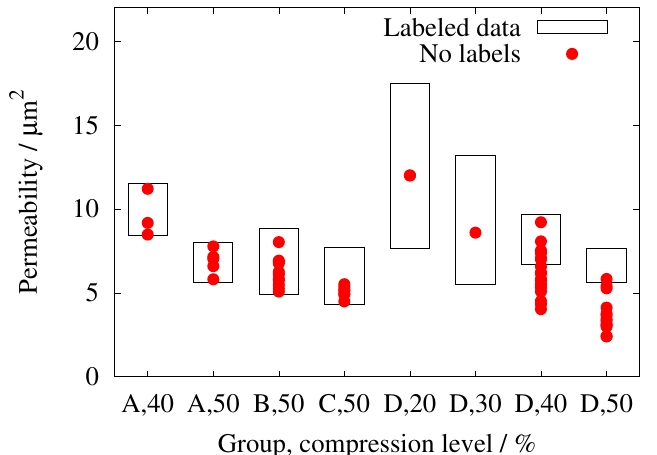
Figure 9. Predictions on unlabeled data, compared with the minimum and maximum values of the same group of labeled